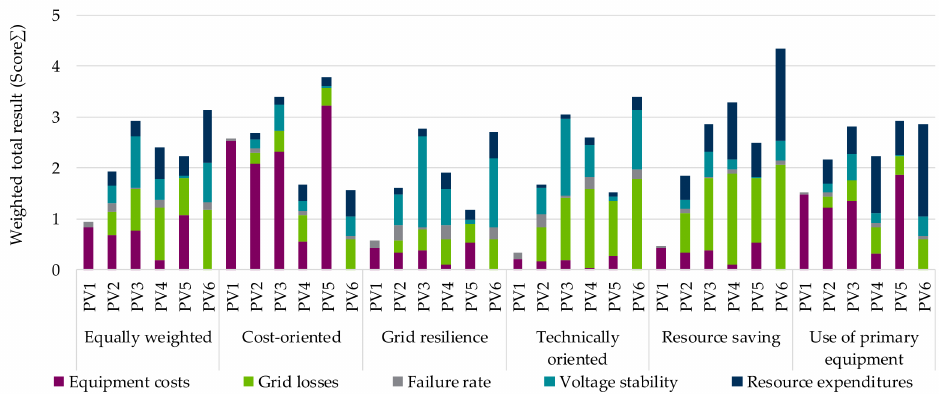
Figure 14. Exemplary overall results of different weightings of the secondary assessment model for six planning variants